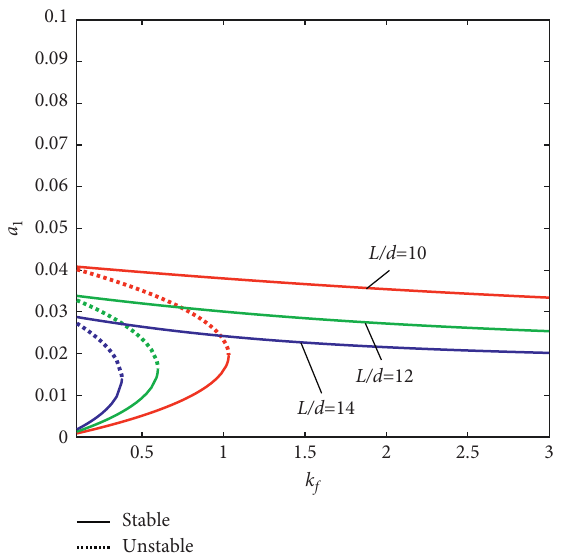
Figure 22: Amplitude versus cutting force coefficient with different ply angles ( σ � 2, c � 0.01, L/d � 10, case